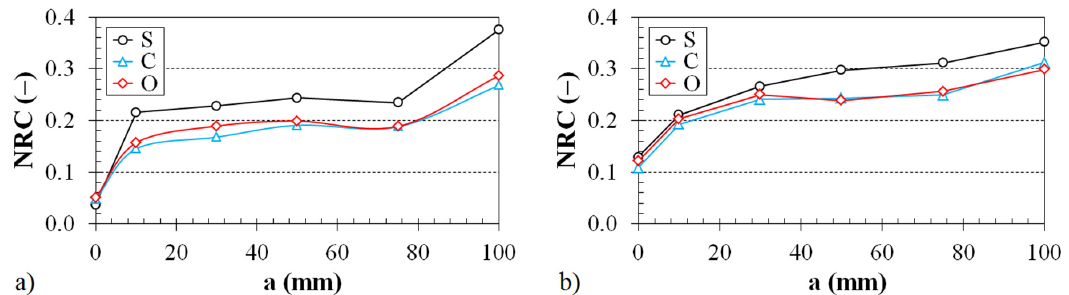
Figure 7. E ff ect of material structure on the noise reduction coe ffi cient vs. air gap size dependencies Figure 7. Effect of material structure on the noise reduction coefficient vs. air gap size dependencies for the investigated ABS samples with the following thicknesses: ( a ) 10 mm and ( b ) 20 mm.